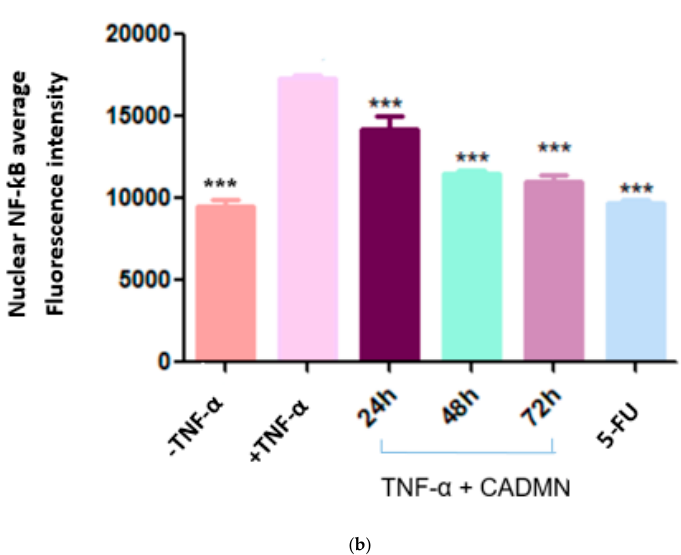
Figure 8. ( a ) Translocation of NF- ƙ B was estimated in untreated cells (-TNF- α ), cells treated with TNF- α (+TNF- α control), cells treated with both TNF- α and CADMN, and cells treated with TNF- α and 5-FU, ( b ) Quantification analysis of nuclear NF- ƙ B fluorescence intensity. Data were expressed as mean ± SD. *** p < 0.001 indicates significant difference as compared to control (+ TNF- α ). Microphotographs were captured with a Leica Confocal microscope, magnification 20 × and scale bars 100 µ m.